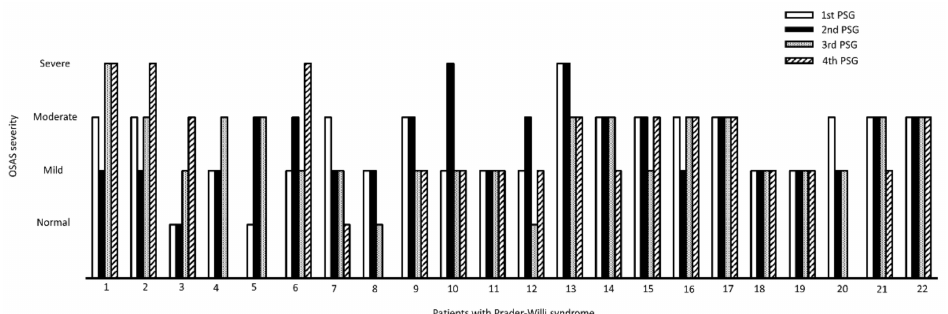
Figure 1. The illustration of OSAS severity in patients of Prader–Willi syndrome. OSAS severity varied in some patients, but it rarely resolved spontaneously during 4-year longitudinal